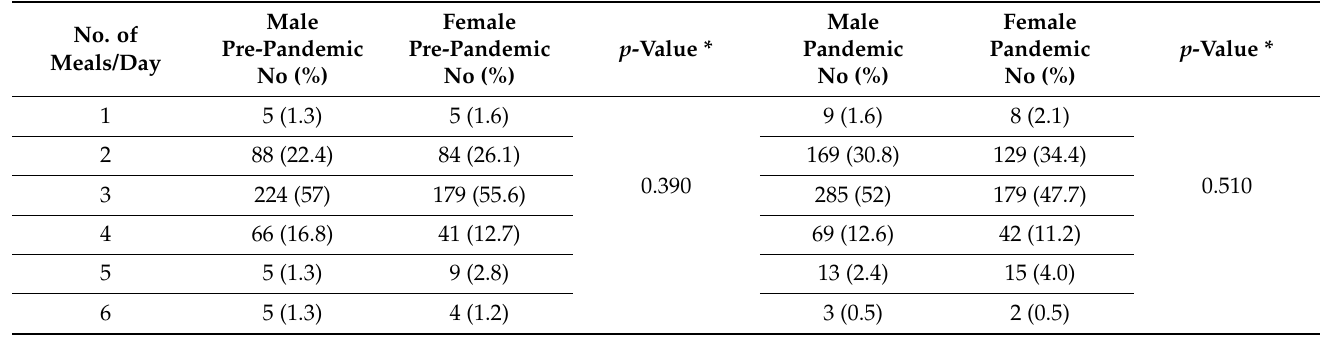
Table 3. The number of meals per